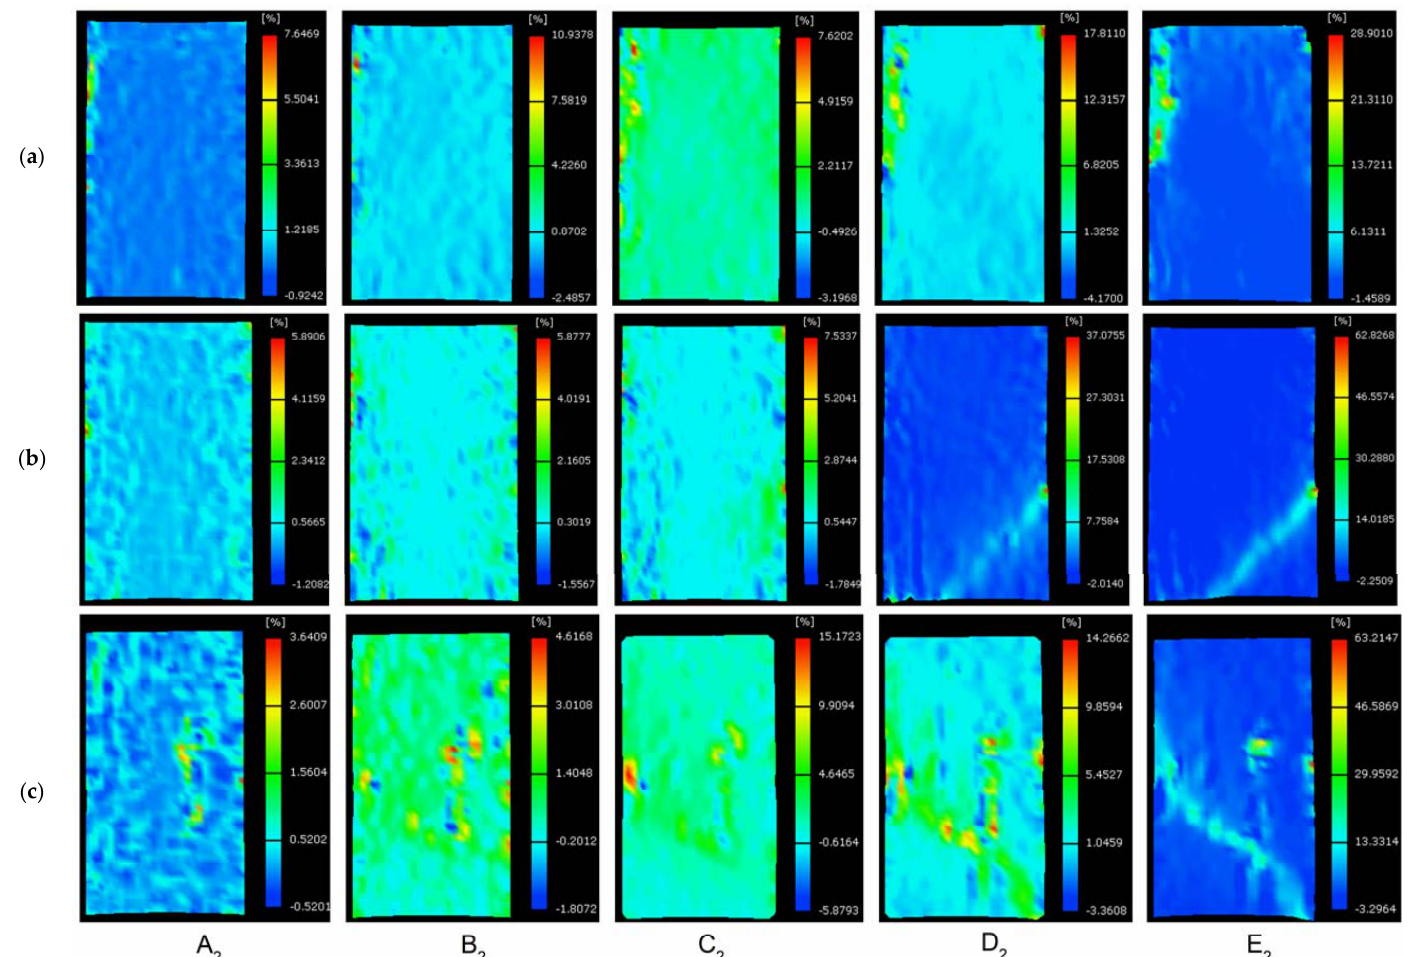
Figure 6. The major strain field obtained by ( a ) L1; ( b ) L2; ( c ) L3 in triaxial compression.